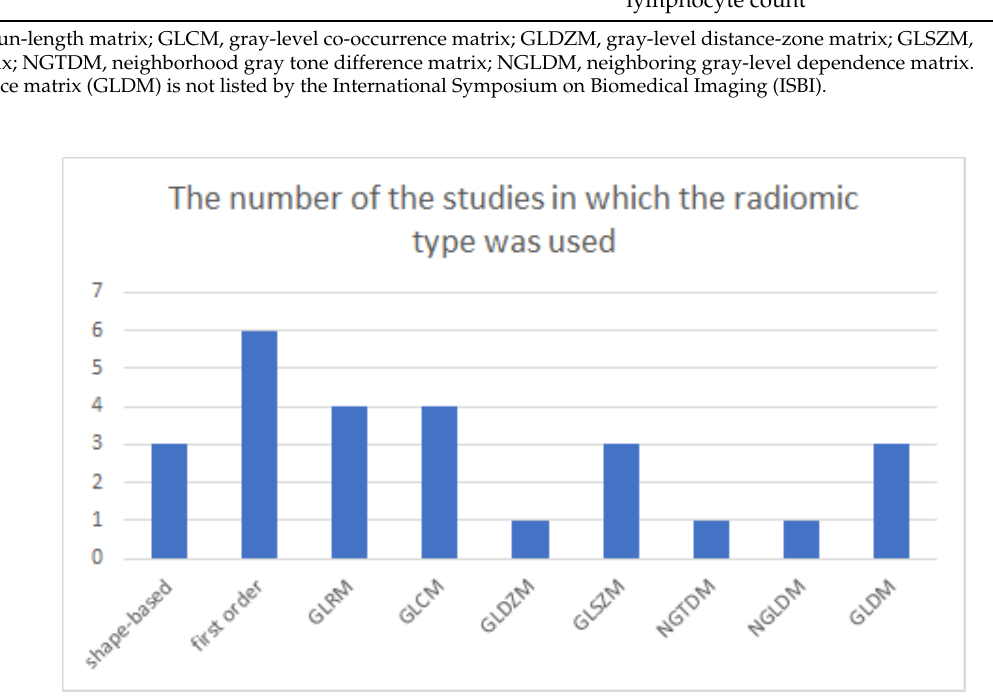
Figure 6. The number of the studies in which the radiomics type was used.